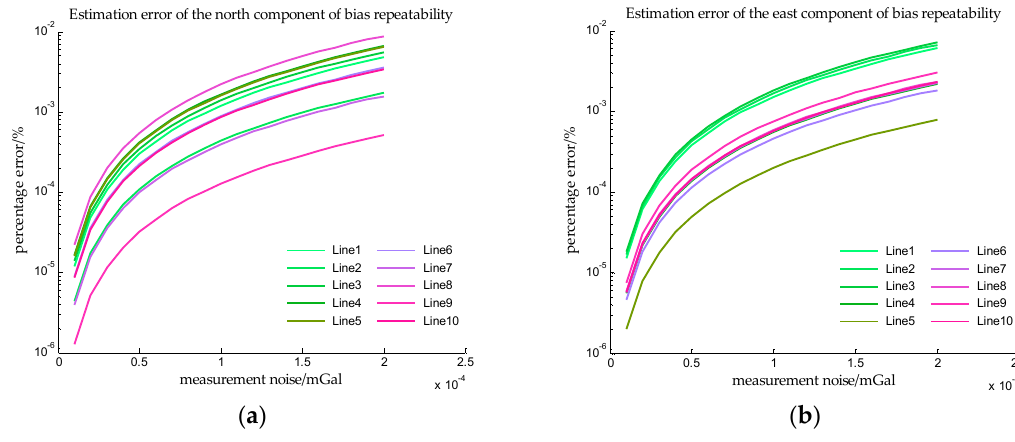
Figure 14. The estimation error of accelerometer bias in simulation III. ( a ) is the estimation error of the north component of the bias repeatability, and ( b ) is the estimation error of the east component of the bias repeatability.